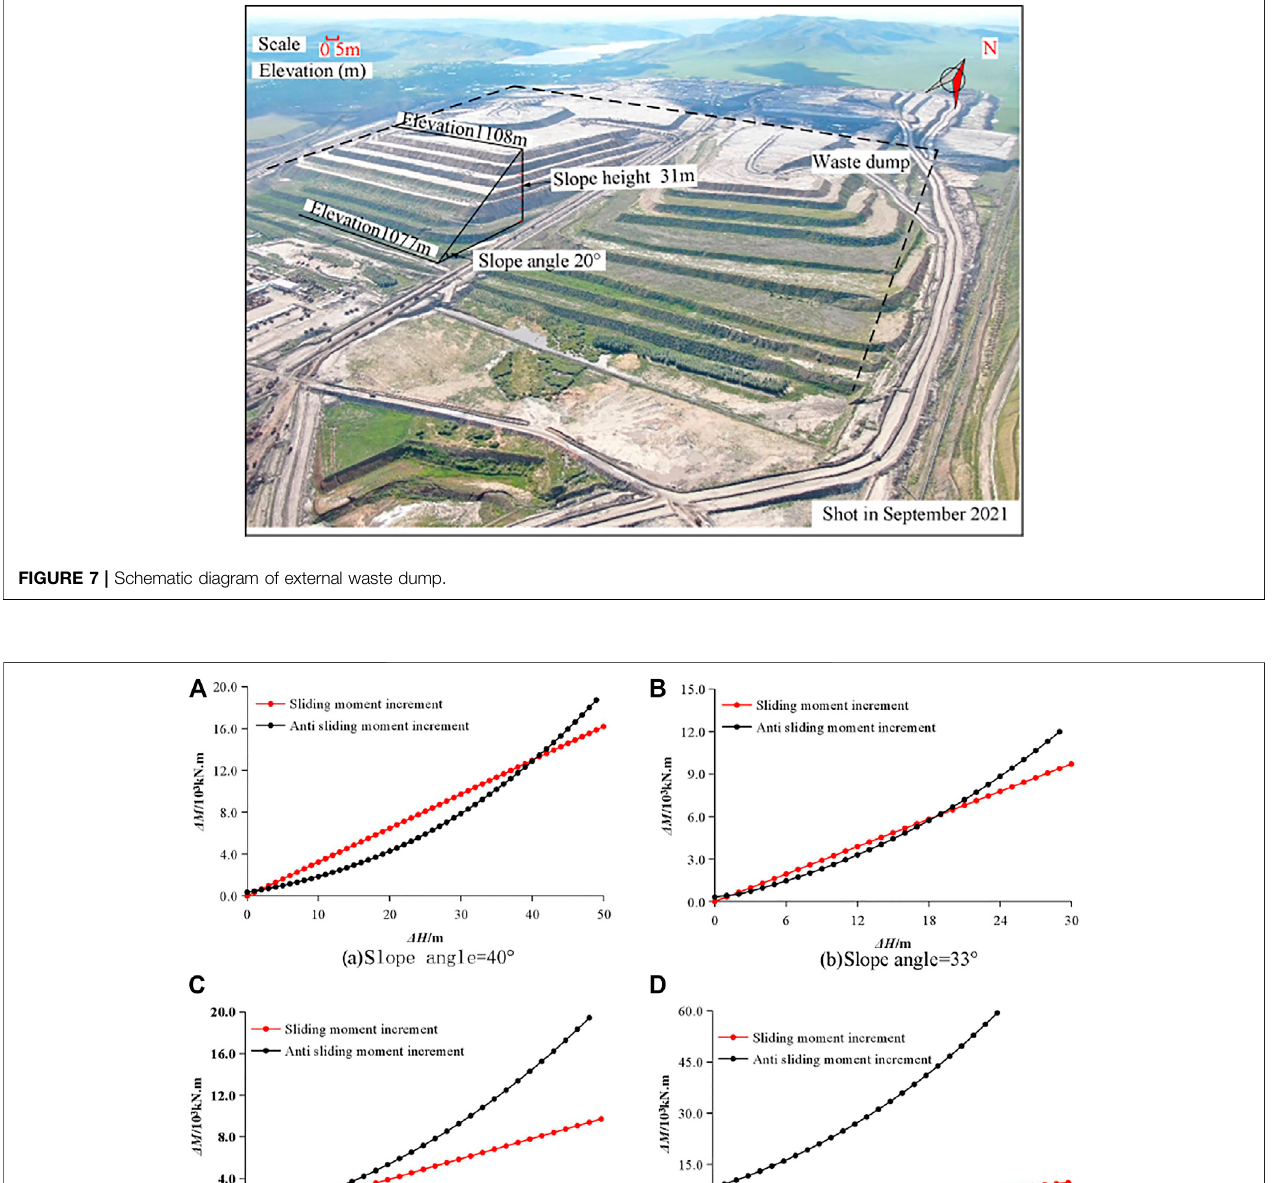
Frontiers in Earth Science |